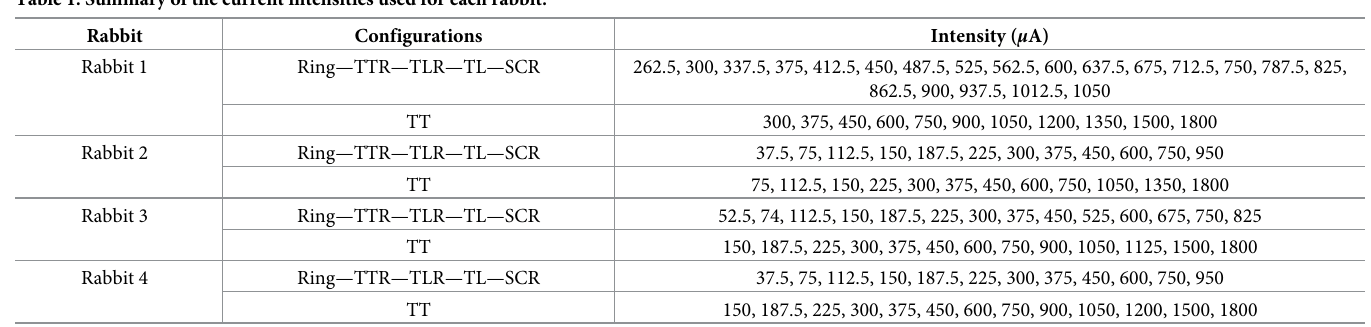
Table 1. Summary of the current intensities used for each